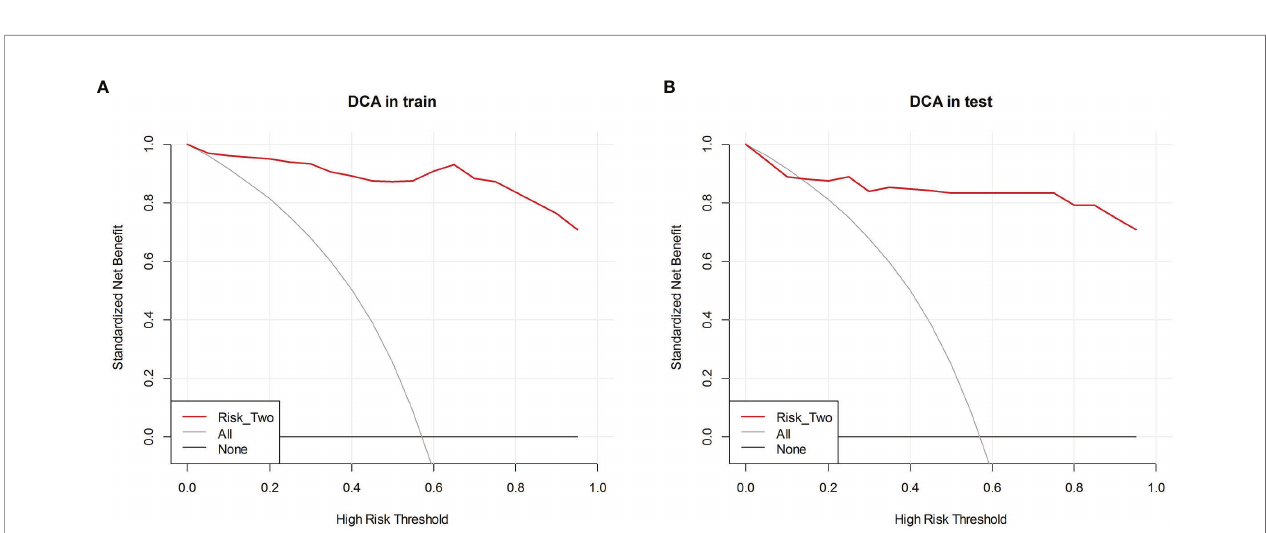
FIGURE 5 | Decision curve analysis (DCA) of each model in predicting BRAF V600E Mutations for papillary thyroid carcinoma (PTC). The vertical axis measures standardized net bene fi t. The horizontal axis shows the corresponding risk threshold. The DCA showed using the risk_two radiomics (red curve) derived in